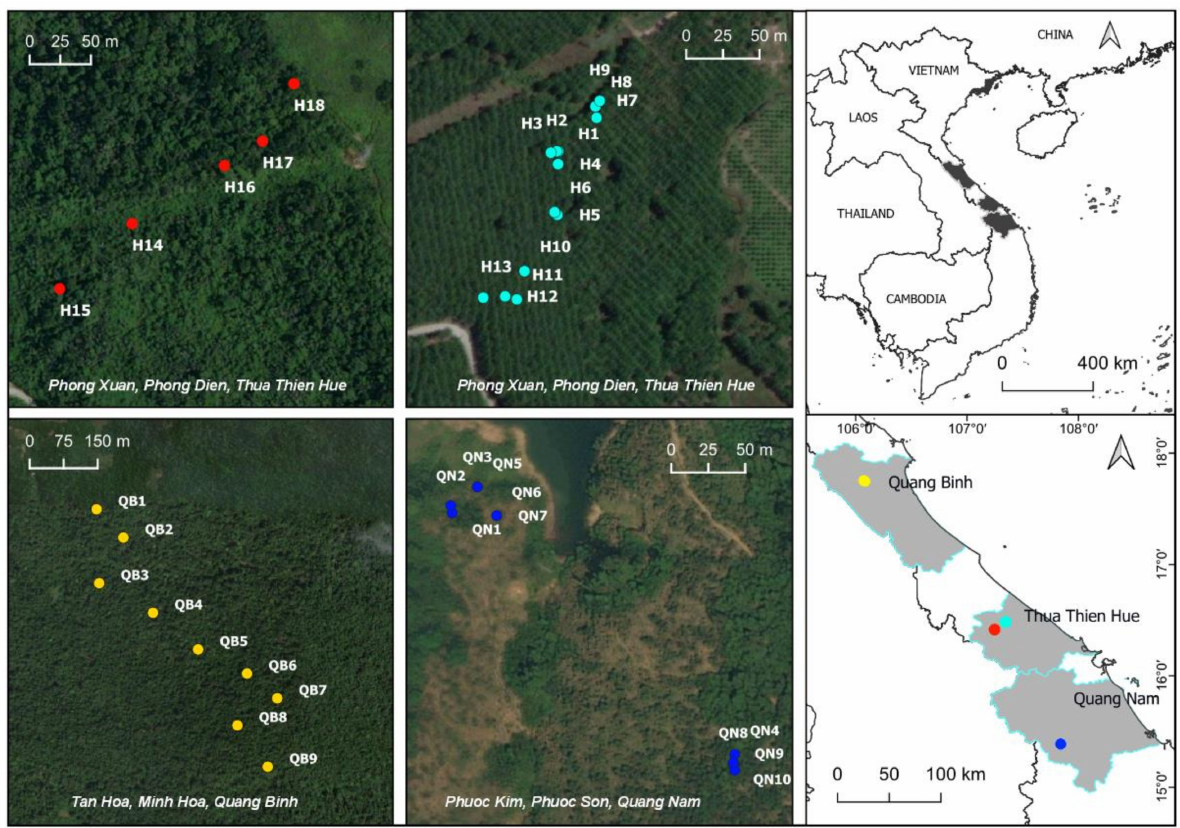
Figure 1. Map showing collection sites of three populations of M. officinalis in central Vietnam.